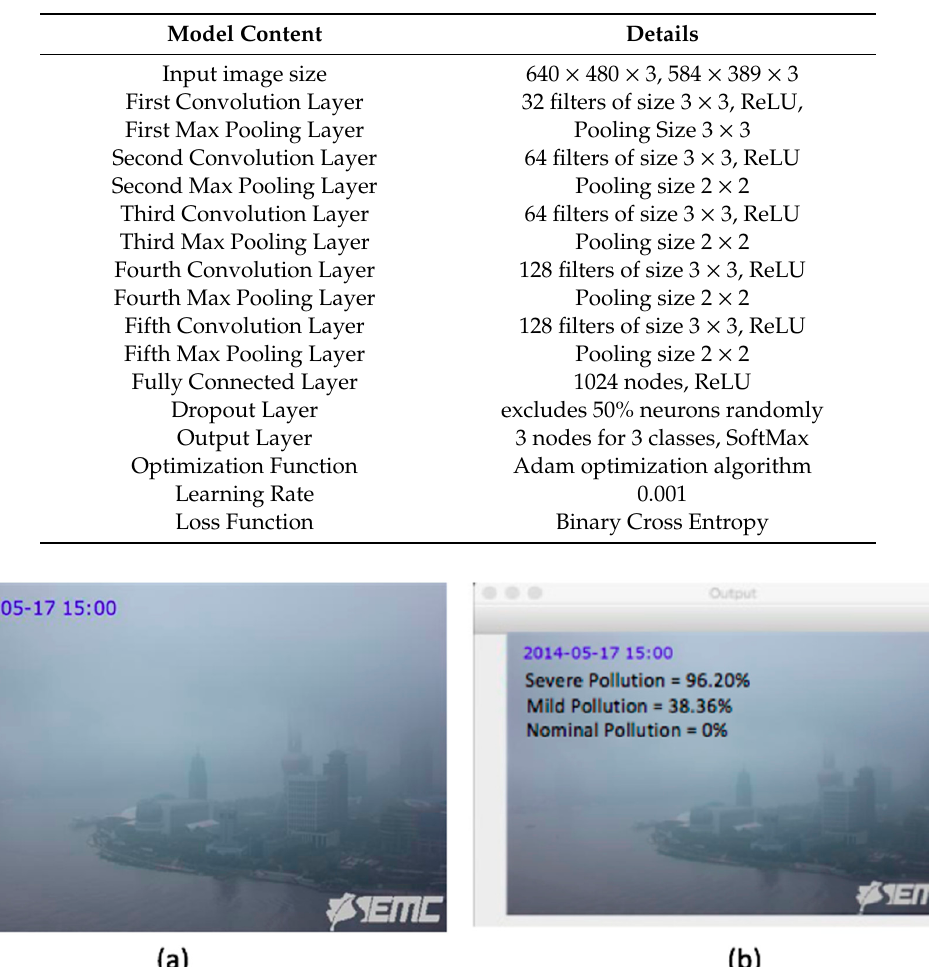
Table 2. Visual Geometry Group (VGG) Net Architecture.